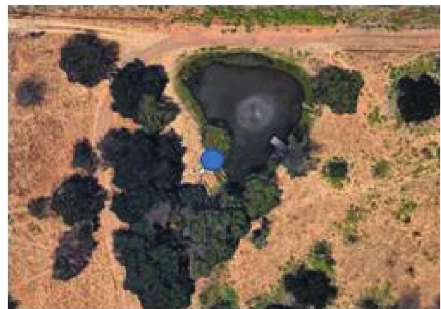
Figure 13: Sampling location near California black poplar tree for Field 21 16S survey.